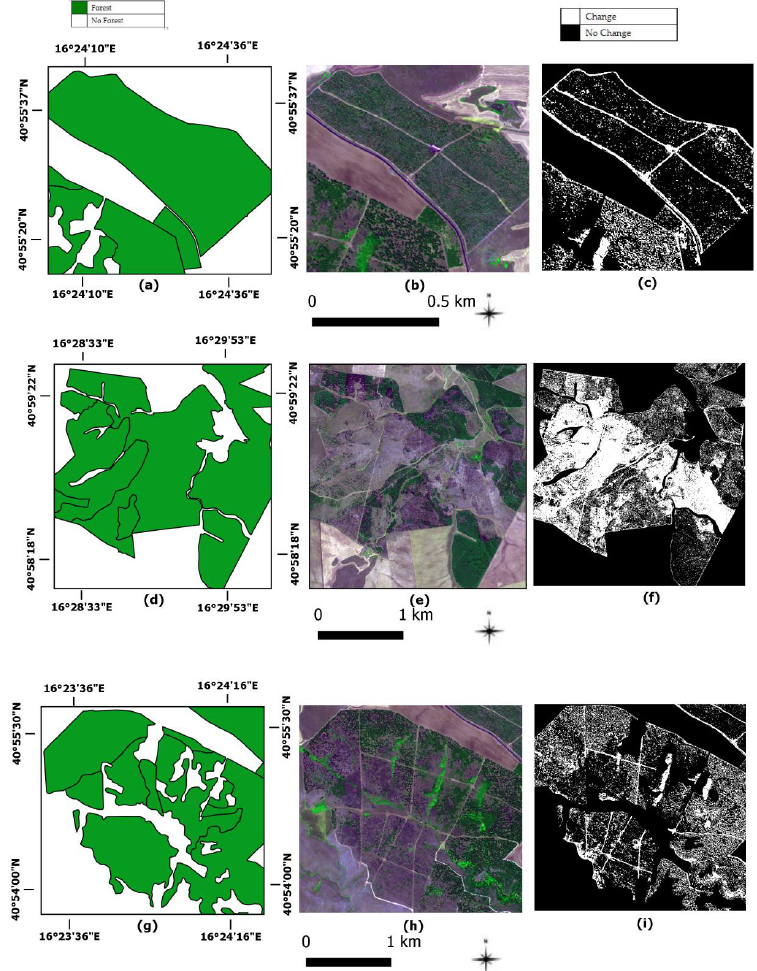
Figure 8 Figure 8. Experiment 2.b—CCA_VHR close-up area from Figure 7, Italian site: ( a – c ) close-ups of needle leaved forest in Figure 7c, blue circle; ( d – f ) close-ups of broadleaved forest in Figure 7c, yellow circle; and ( g – i ) close ups of mixed forest in Figure 7c, red circle. Such changes might be due to